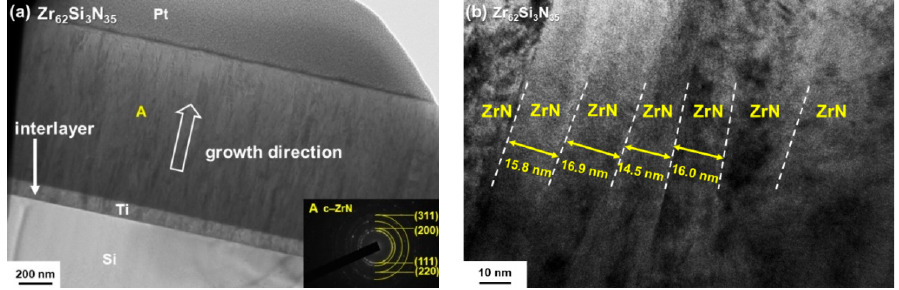
Figure 10. ( a ) Cross ‐ sectional TEM image and SAED pattern and ( b ) high ‐ magnification TEM image